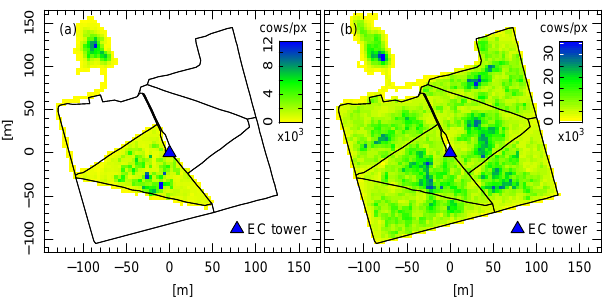
Figure 13. Cow density distribution (a) for one grazing cycle (i.e., two consecutive days) and (b) for the entire study field integrated over the full grazing season in 2013. The color of each pixel (4 × 4m) represents the number of data points collected at 5s time resolution with the GPS trackers of all cows. Note the different color